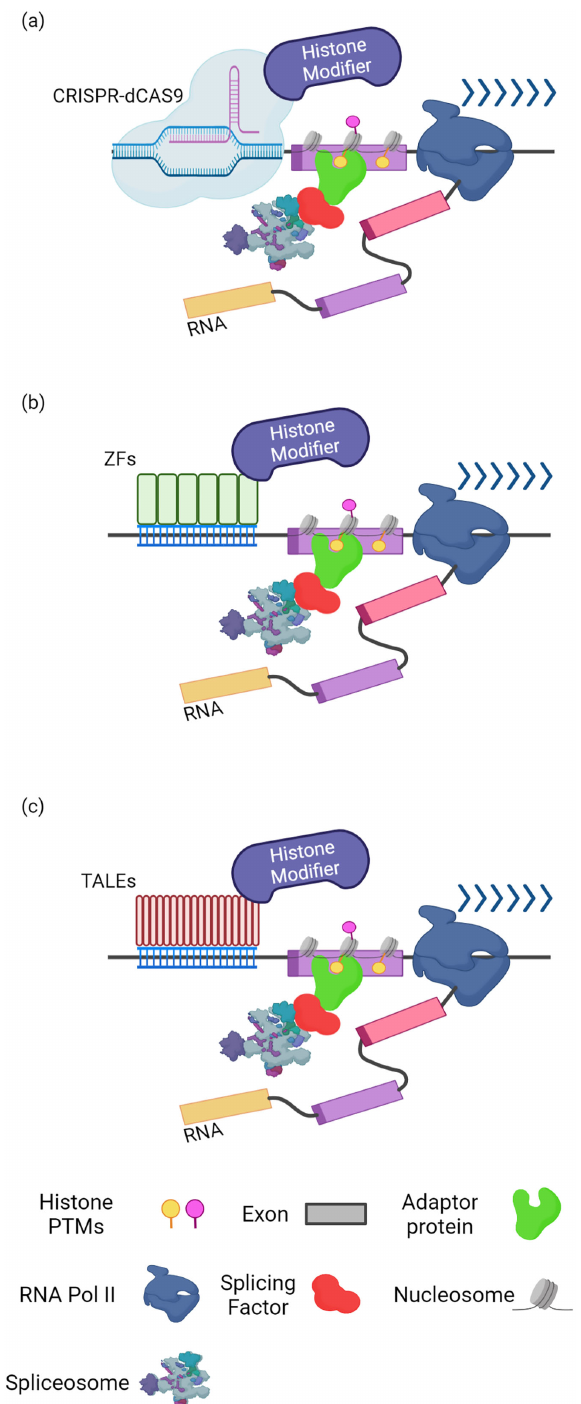
Figure 3. Overview of targeted epigenetic editing tools for localized modification of histone post- translational modifications. ( a ) CRISPR-dCas9 can target specific genomic locations by exploiting complementarity with a guide RNA. ( b ) Zinc Finger proteins can recognize 3 bps of DNA and the fusion of 6 ZFs can identify specific 18 bps sequences. ( c ) TALE domains can recognize a single-base pair and the fusion of several repeats distinguishes a specific locus. Created with